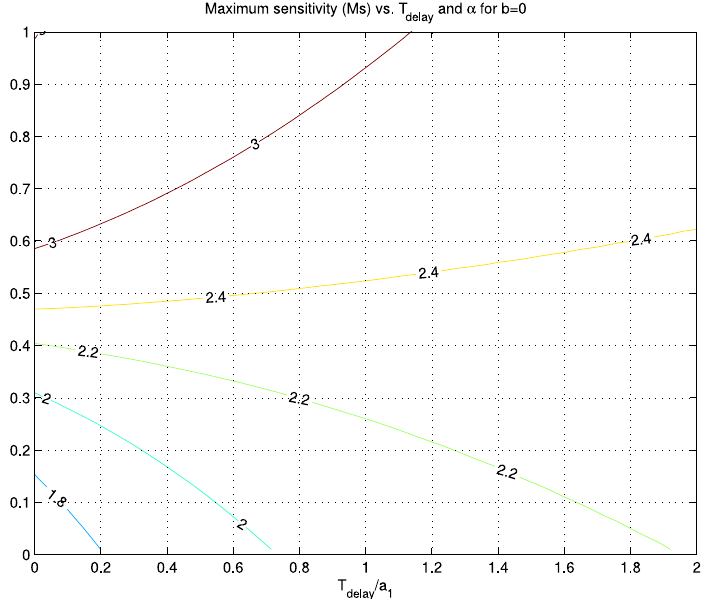
Figure 5. Closed-loop maximum sensitivity (M S ) for G ( s ) and controller parameter b = 0 at different values of process parameters T delay and α.